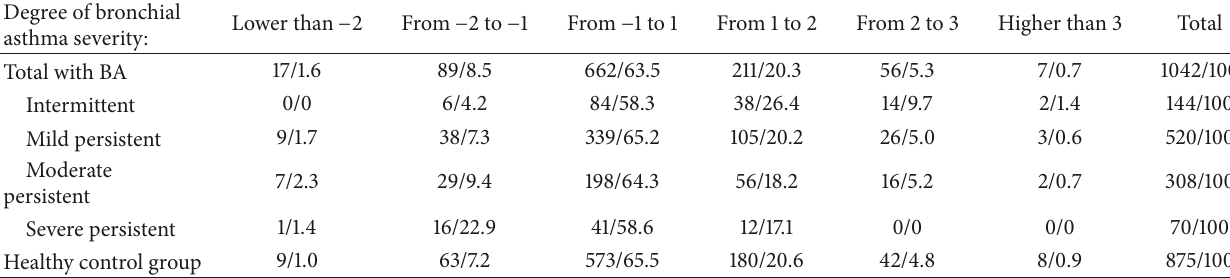
Table 2: Distribution of patients from BA various weight using the WHO 𝑍 -score system (absolute number/fraction in %). Cross-tabulation demonstrates dependency between 𝑍 -score and asthma severity ( 𝜒 2 = 45.6 , 𝑝 = 0.0009